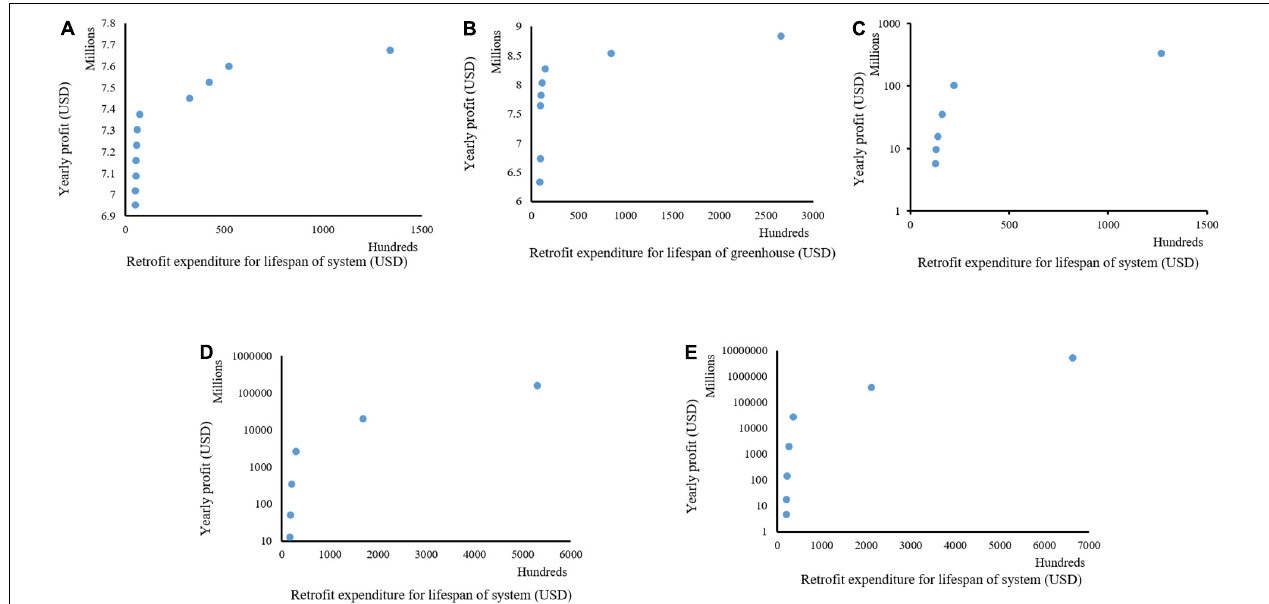
FIGURE 7 | Different combinations of cost of retrofitting and yearly profit derived at different sizes of a plant production system for Case 1; size 1 (A) , size 2 (B) , size 3 (C) , size 4 (D) , and size 5 (E).